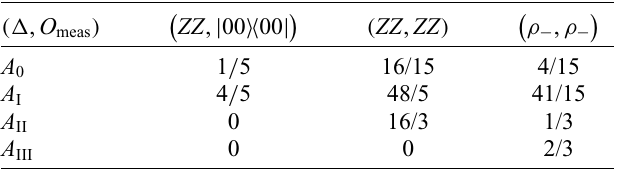
TABLE I. Coefficients A 0 , A I , A II , and A III appearing in Eq. (40), for the 2-qubit case. The first row provides a pair of the initial and measurement operators ((cid:13) , O meas ) . We have assumed that the average fidelity of the noise E is close to 1, can be applied nearly noise- so that the inverse unitary U i m + 1 less (see Sec. VIII E for details). The operator ZZ is Z ⊗ Z , and = | 00 (cid:11)(cid:12) 00 | − | 11 (cid:11)(cid:12) 11 | . By choosing proper operators, we can ρ − : set some coefficients zero, so that experimental estimations of C λ ( E ) become